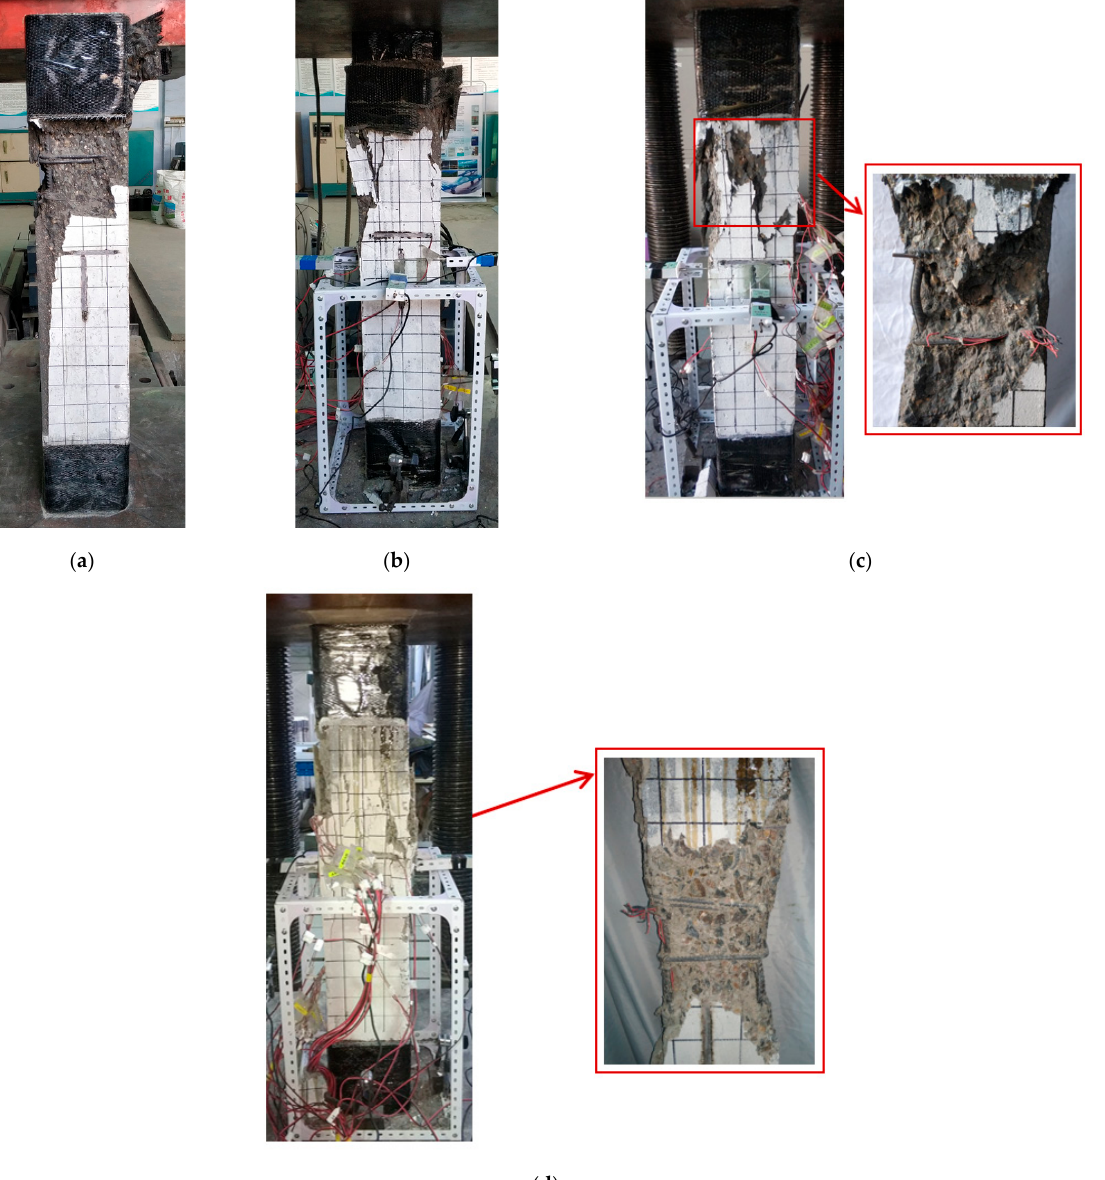
Figure 5. The failure mode of the columns under axial compression: ( a ) specimen A1; ( b ) specimen A2; ( c ) specimen A3; and ( d ) specimen A4